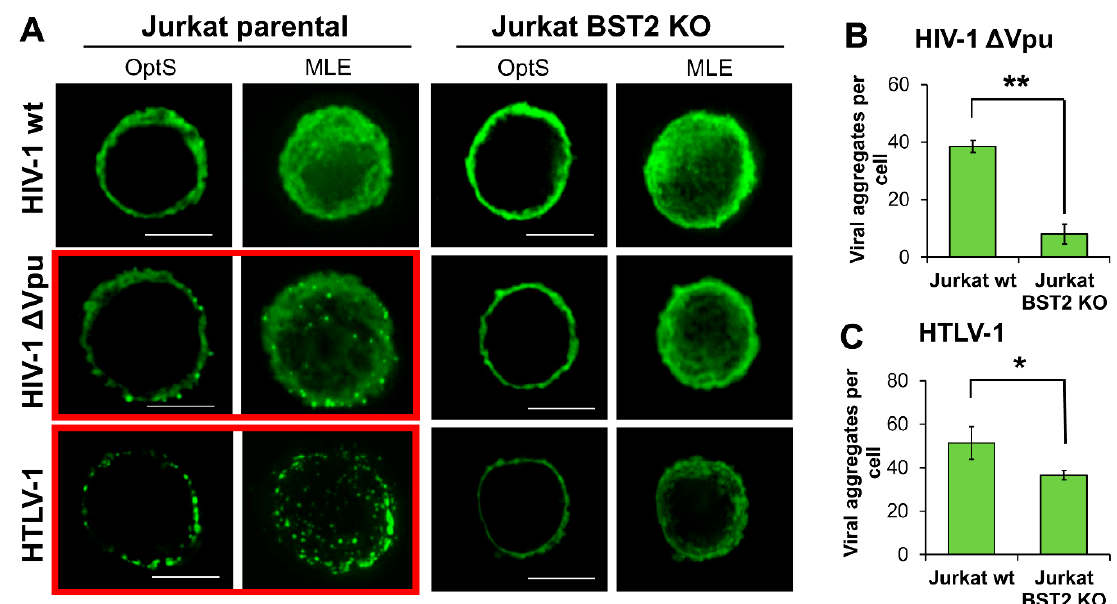
Figure 6. The patterns of HIV-1 and HTLV-1 viral particle expression in BST2-positive and negative T cell lines. ( A ) Jurkat parental or KO cells were transfected with wt or Vpu(-) HIV-1 or HTLV-1 packaging plasmid and followed fixation / permeabilization stained with the respective anti-Gag Ab. Cells were analyzed using fluorescence deconvolution microscope, and presented as a 0.3- µ m optical slices through the middle plane of cells (OptS) or as Z-stack one plane projections obtained by Maximum Likelihood Estimation (MLE) algorithm (scale bar, 5 µ m). At least 4-6 cells per sample were analyzed to demonstrate representative cells. The levels of clusterization for HIV-1 ∆ Vpu ( B ) and HTLV-1 ( C ) were quantified using ImageJ Threshold, Watershed, and Analyze particles software options. A size limit for clusters was set to calculate numbers of clusters per cell. The data obtained from several cells and from di ff erent slides were averaged and presented. * and **, the di ff erences between wild type and KO cells are statistically significant at p < 0.05 and p < 0.01, respectively.